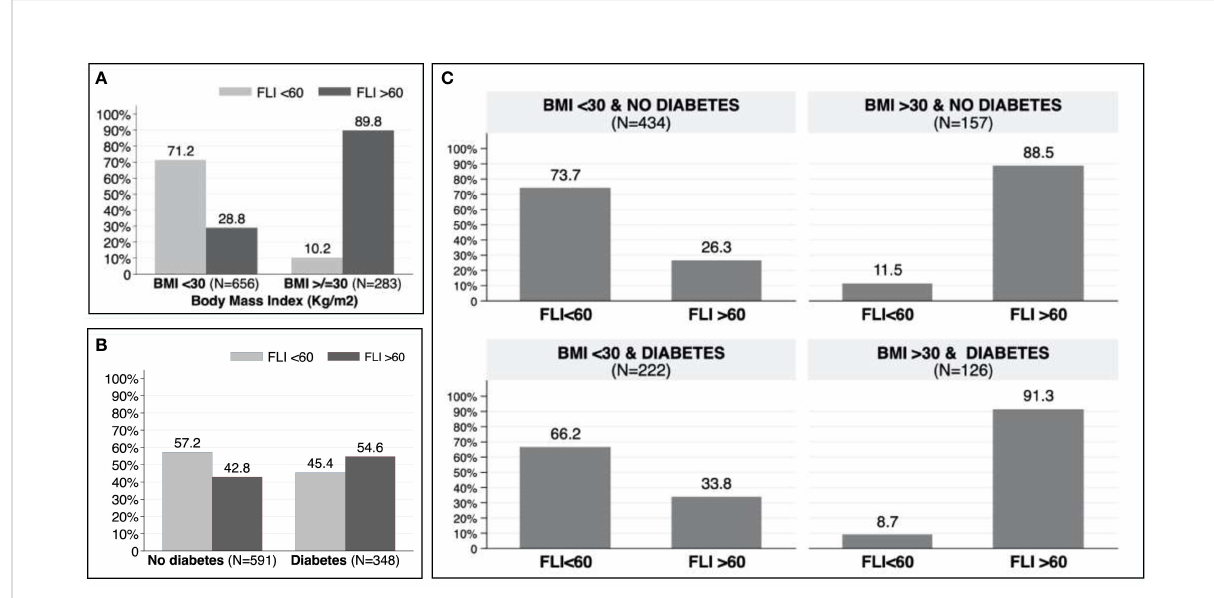
FIGURE 3 (A) Prevalence of non-alcoholic fatty liver disease in patients with and without obesity. (B) Prevalence of non-alcoholic fatty liver disease in patients with and without type 2 diabetes mellitus. (C) Prevalence of non-alcoholic fatty liver disease according to obesity and/or type 2 diabetes